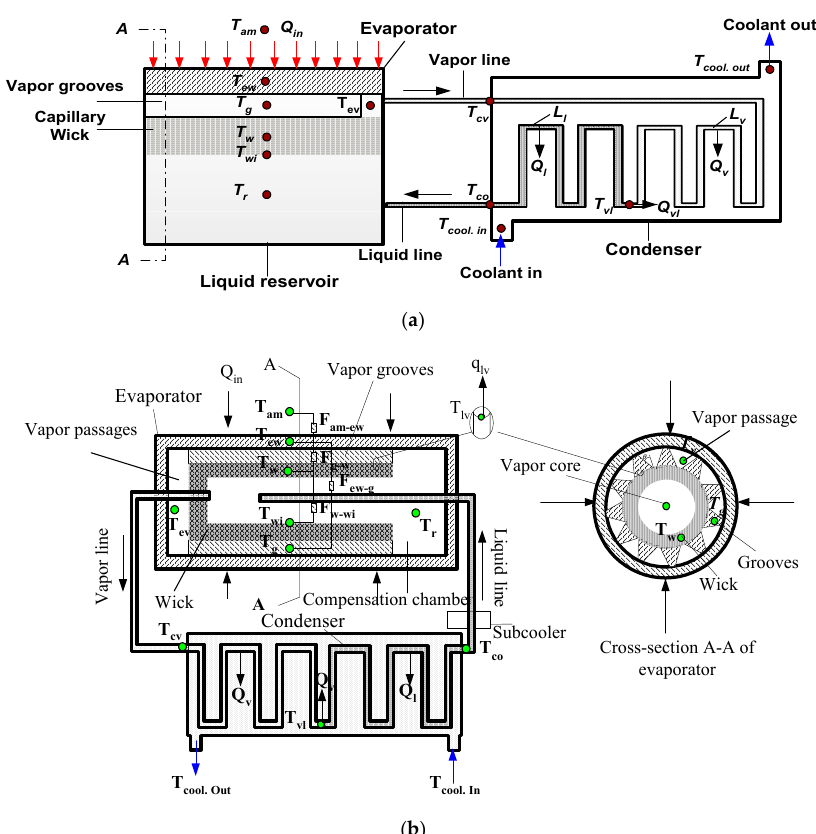
Figure 1. Schematics of the FLHP and CLHP: ( a ) Loop heat pipe (LHP) with a flat evaporator (FLHP); ( b ) LHP with a cylindrical evaporator (CLHP).